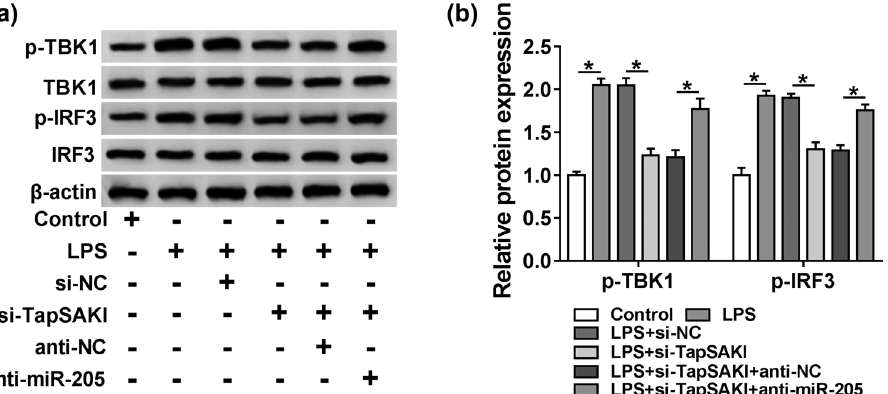
Figure 7: TapSAKI knockdown blocked IRF3 signaling in LPS - induced HK - 2 cells via miR - 205. ( a and b ) The expression levels of p - TBK1, TBK1, p - IRF3, and IRF3 by western blot in HK - 2 cells transfected with or without si - NC, si - TapSAKI, si - TapSAKI + anti - NC, or si - TapSAKI + anti - miR - 205 before LPS treatment. * P <